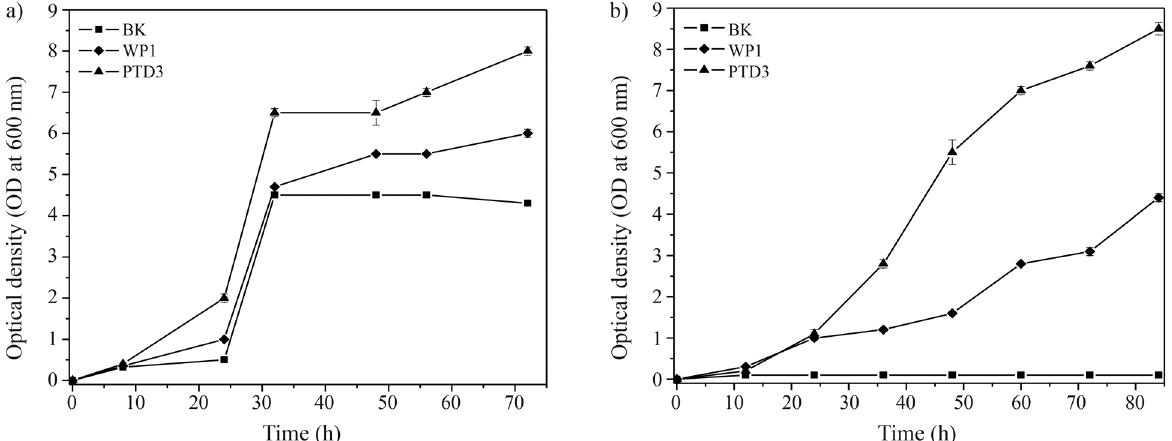
Figure 1 - Growth of WP1 and PTD3 (a) in an MS medium, with 3% glucose as the carbon source, (b) in an MS medium with 3% xylose as the carbon source. Baker’s yeast (BK; ATCC6037) was used as positive control. The experiments were carried out in triplicate, the error bars indicating standard de- viation.